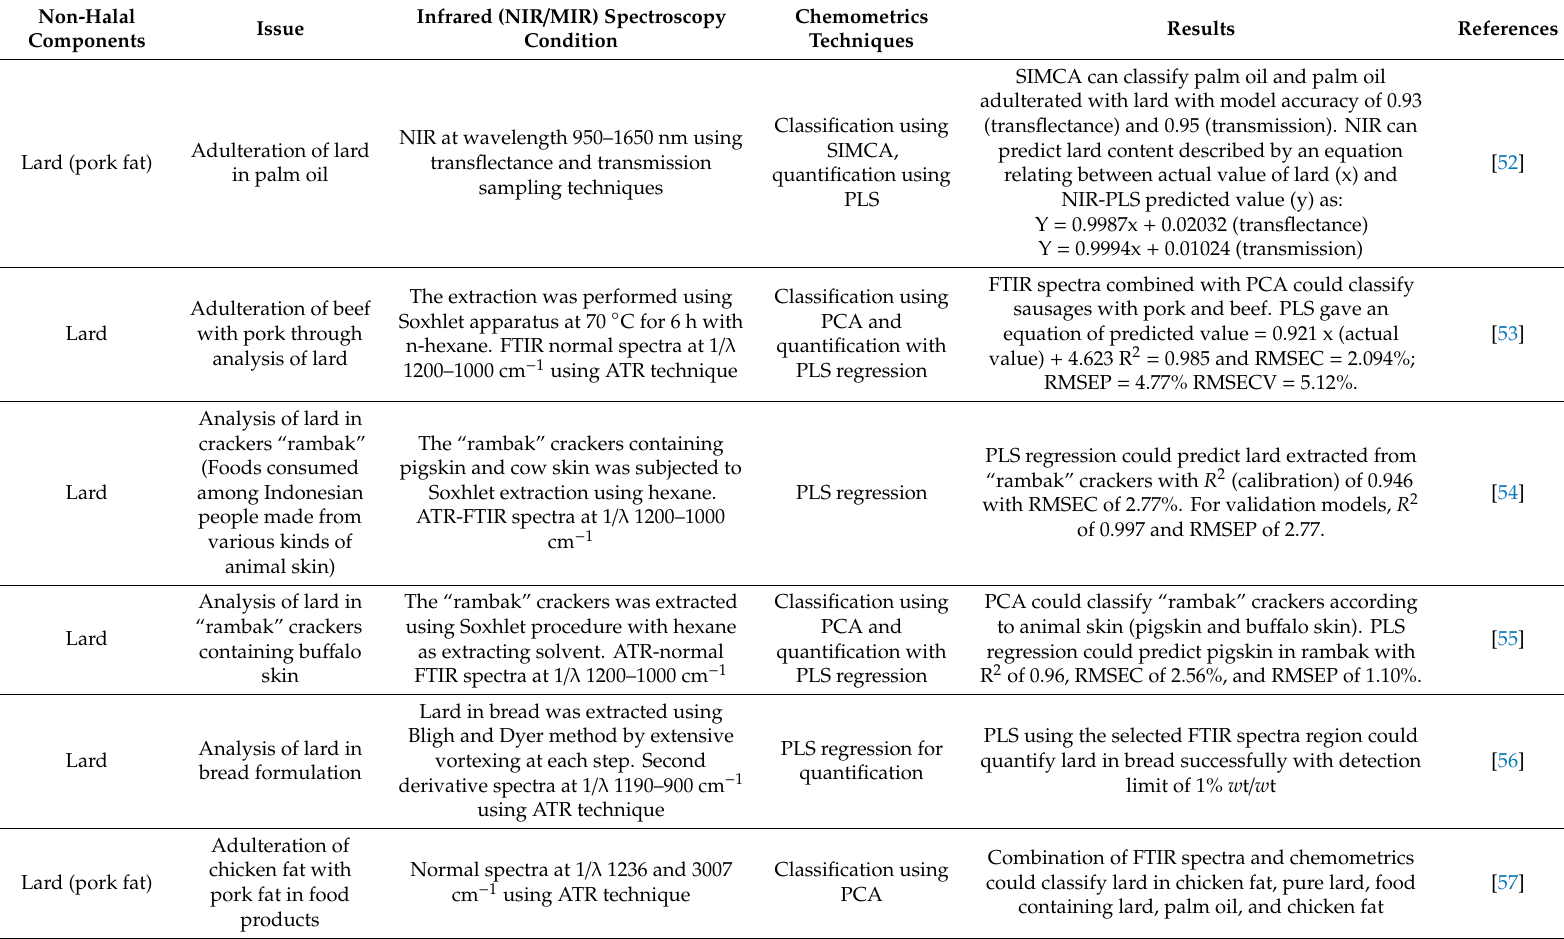
Table 1. The application of near-infrared (NIR) and mid-infrared (MIR) spectroscopy with several chemometrics techniques for analysis of non-halal components in food and pharmaceutical